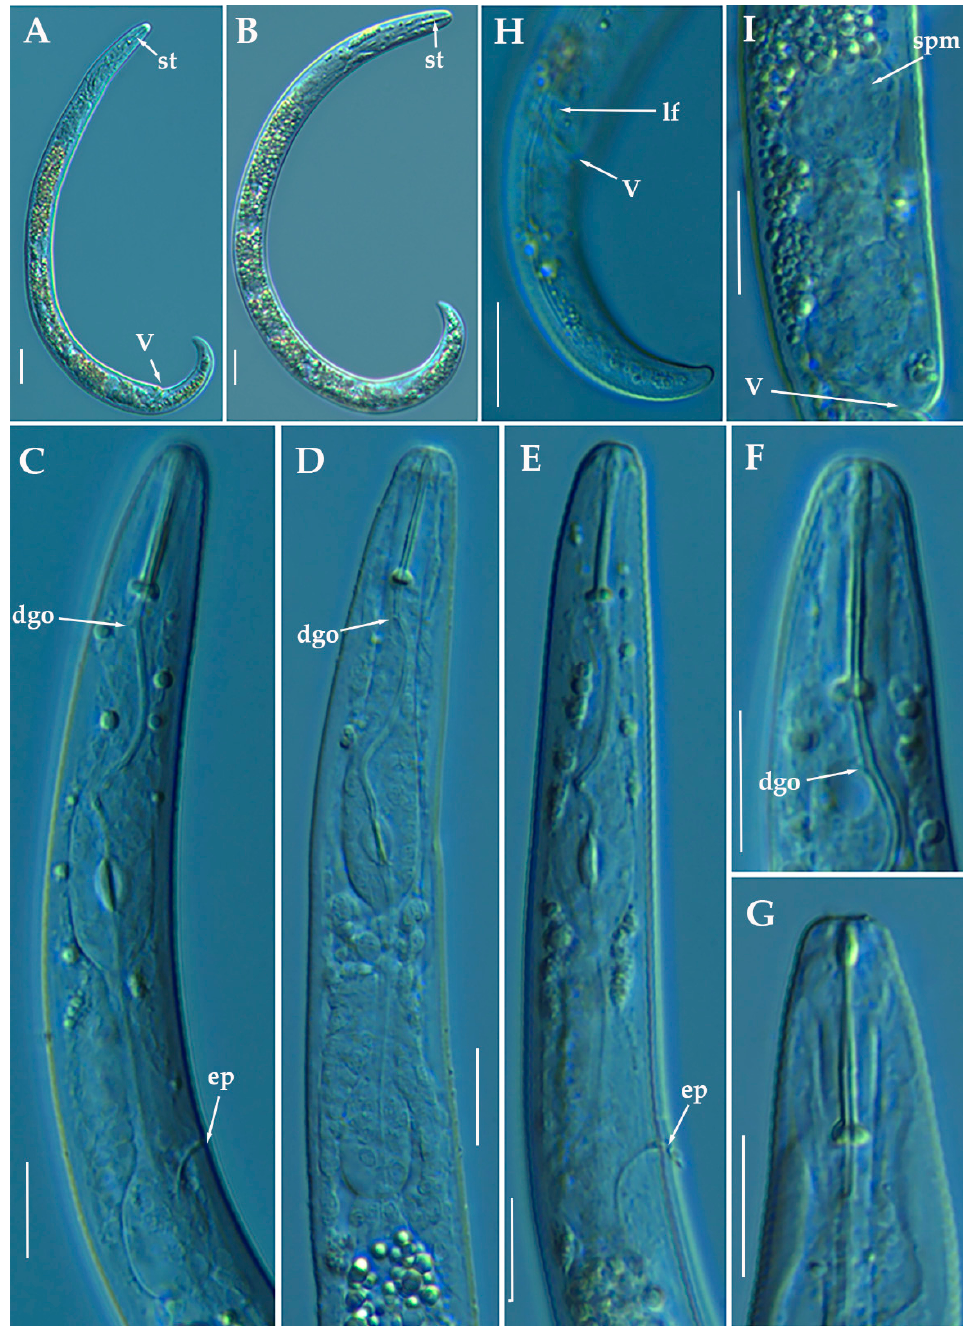
Figure 19. Light photomicrographs of female of Paratylenchus veruculatus Wu, 1962. ( A ): Entire female with stylet and vulva arrowed; ( B ): Fourth-stage juvenile with stylet arrowed; ( C – E ): Female pharyngeal region; ( F – G ): Female lip region; ( H ): Female posterior region with lateral field and vulva arrowed; ( I ): Detail of empty spermatheca (arrowed). Scale bars ( A , B , H = 20 μ m; C – G , I = 10 µ m). (Abbreviations: a = anus; dgo = pharyngeal dorsal gland orifice; ep = excretory pore; lf = lateral field; spm = spermatheca; st = stylet; V = vulva).